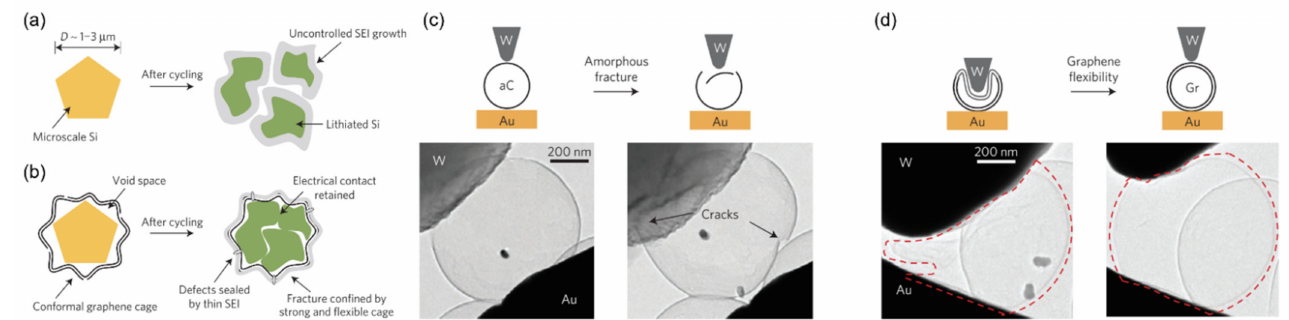
Figure 5. ( a ) The failure mechanism of Si microparticles in the anode during repeated battery cycling. ( b ) Enhanced structural stability and SEI control of Si microparticles with a mechanically flexible graphene cage. ( c ) Schematic and real-time TEM images of applying pressure to the empty shell of amorphous carbon. ( d ) Schematic and real-time TEM images of applying pressure to the graphene cage. Reproduced with permission from ref. [50,59]. Copyright 2017, ACS Publications. Copyright 2016, Nature Publishing